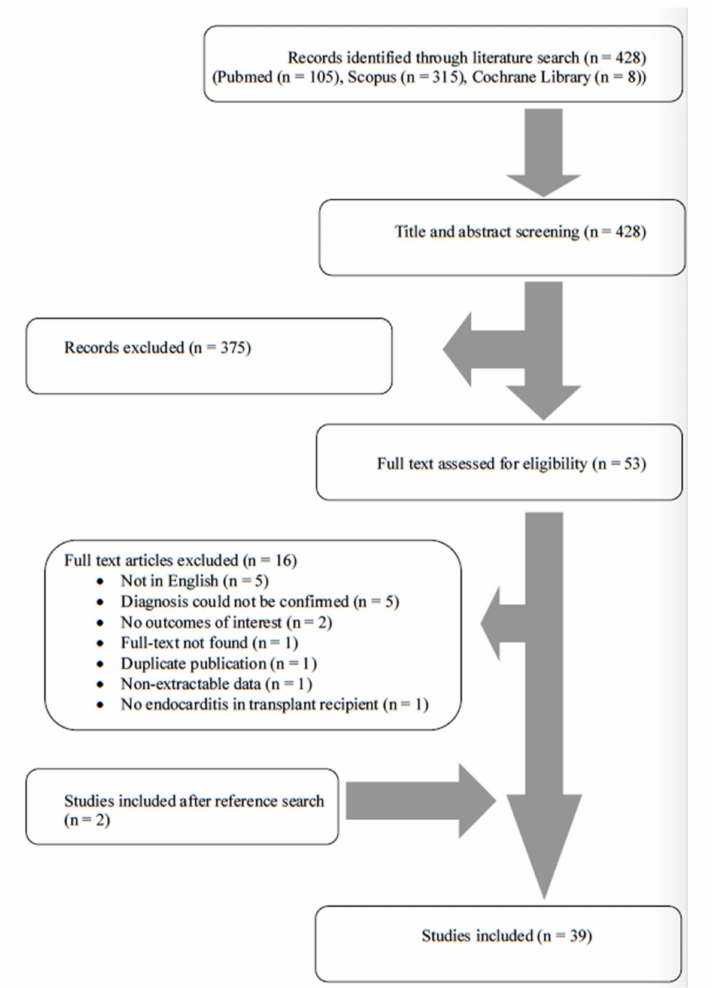
Figure 1. Flow diagram of study